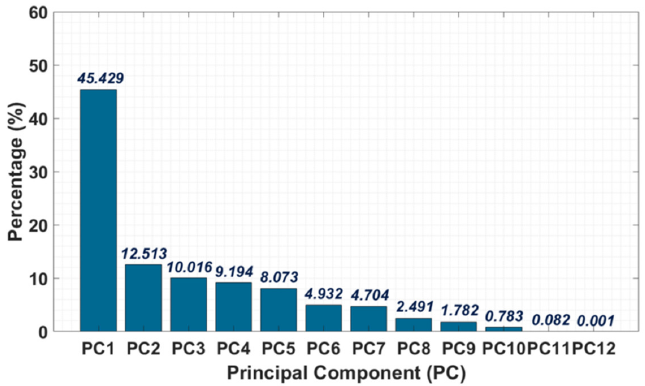
Figure 4. Proportions of total variance interpreted by each of the twelve principal components.